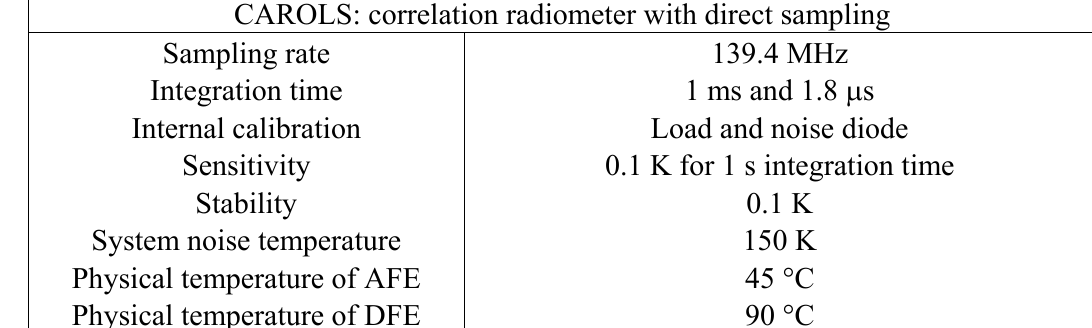
CAROLS: correlation radiometer with direct sampling